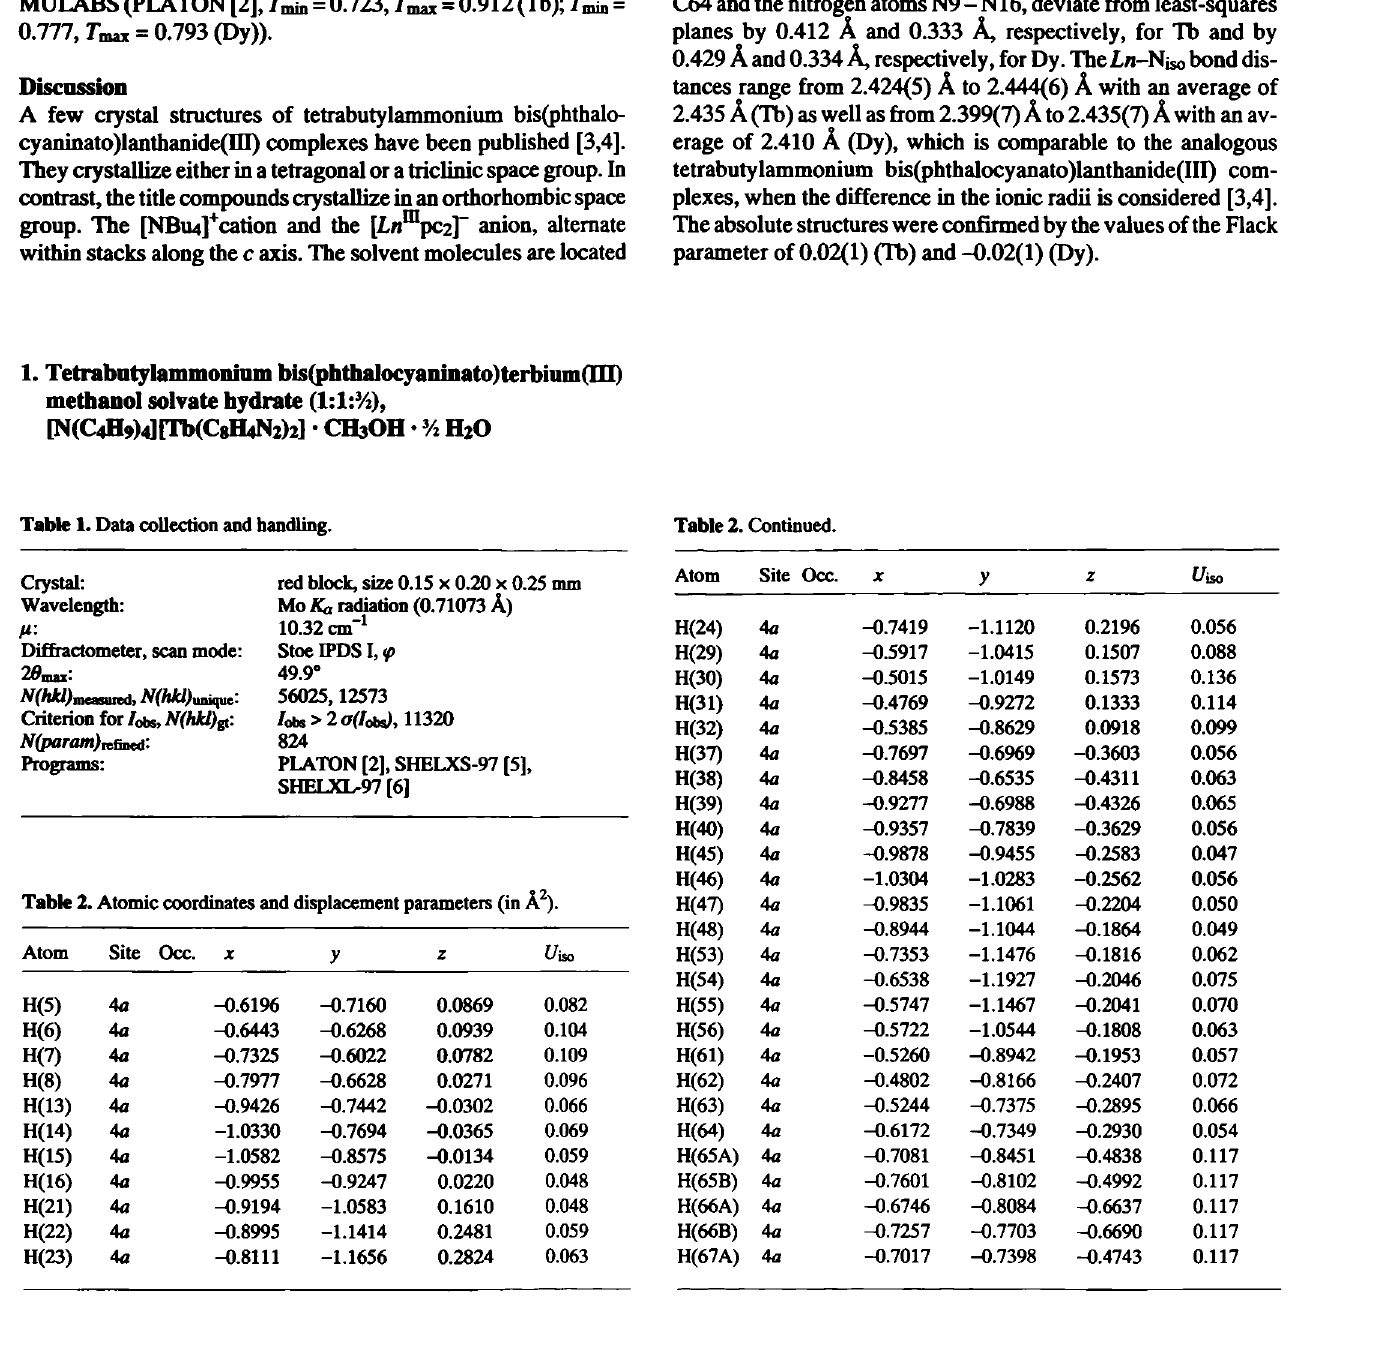
Table 2. Atomic coordinates and displacement parameters (in Ä 2